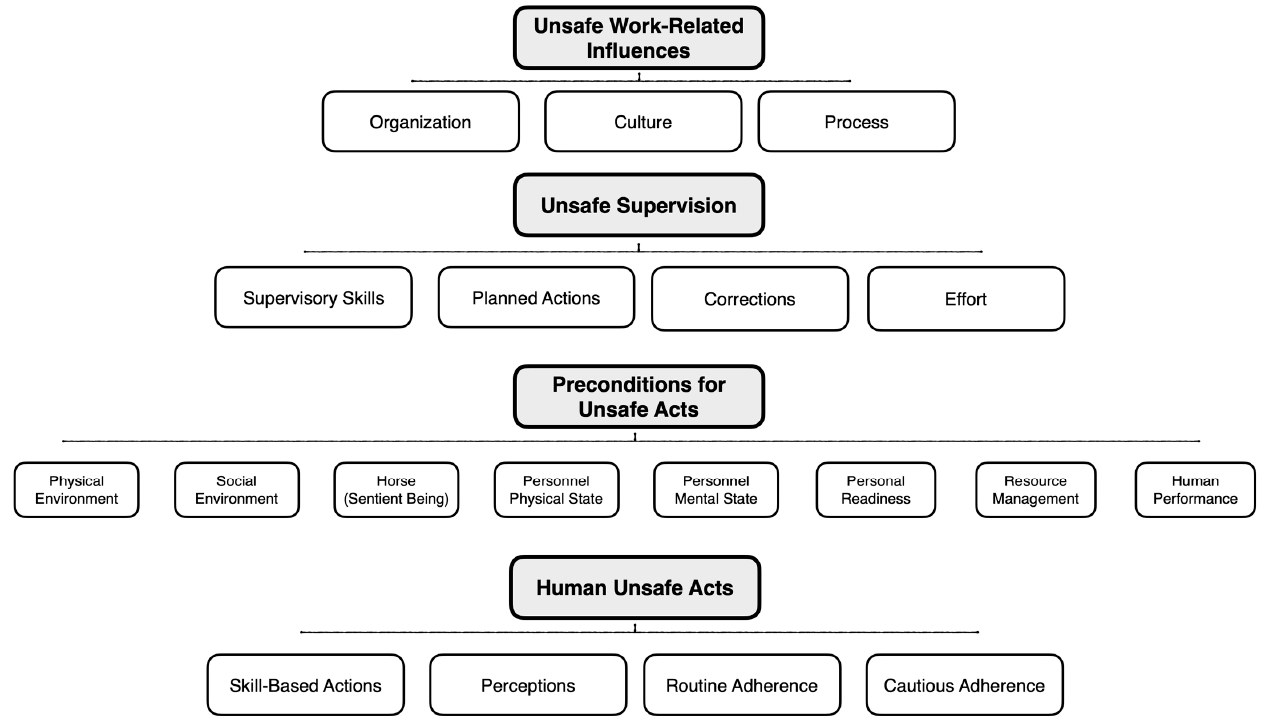
Figure 1. Human factors analysis and classification system with modification to include equestrian industry specific components (HFACS ‐ Eq). industry specific components